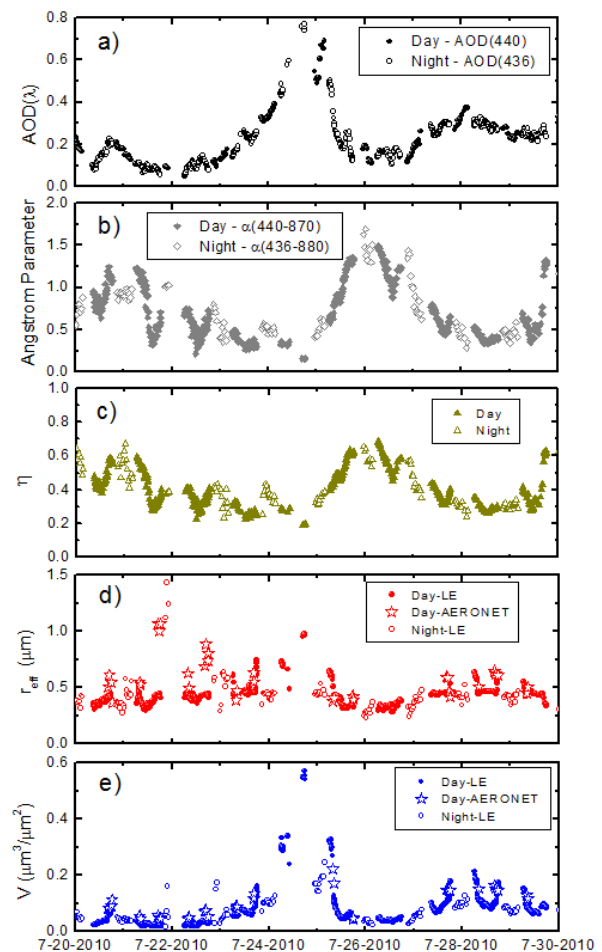
Figure 13. Day-to-night time evolutions of aerosol properties from sun-and-star photometry measurements in the city of Granada from 20 to 30 July 2010. (a) Aerosol optical depth, (b) Ångström param- eter, (c) fine mode fraction, (d) effective radius, and (e) columnar volume aerosol